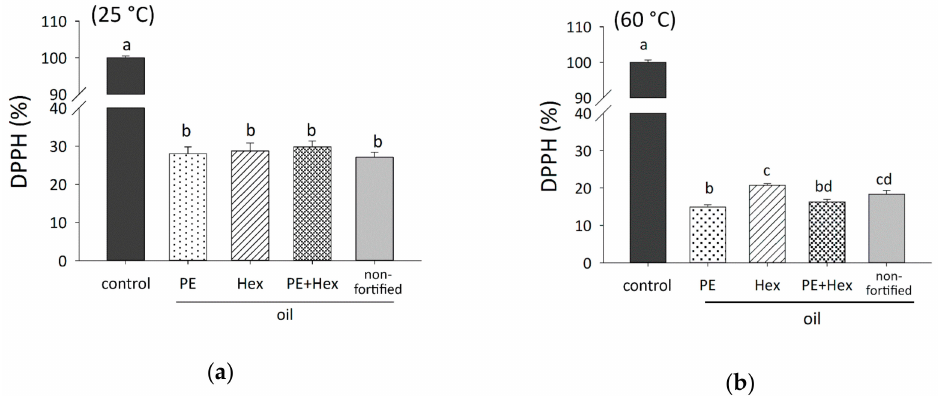
Figure 7. DPPH radical scavenging activity of the fortified and non-fortified oil samples. CPSBO (500 µ l) was incubated with 4 mM PE (16:0 / 18:1) and / or 8 mM hexanal at 25 ◦ C ( a ) and 60 ◦ C ( b ) for 60 min. A total of 25 µ l of the oil samples were dissolved in 1 mL toluene with DPPH (0.25 mM). In the toluene control, DPPH was set to 100% after 60 min. Values are shown as mean + SEM. Each experiment was performed thrice. Di ff erent letters indicate significant di ff erences. Statistical